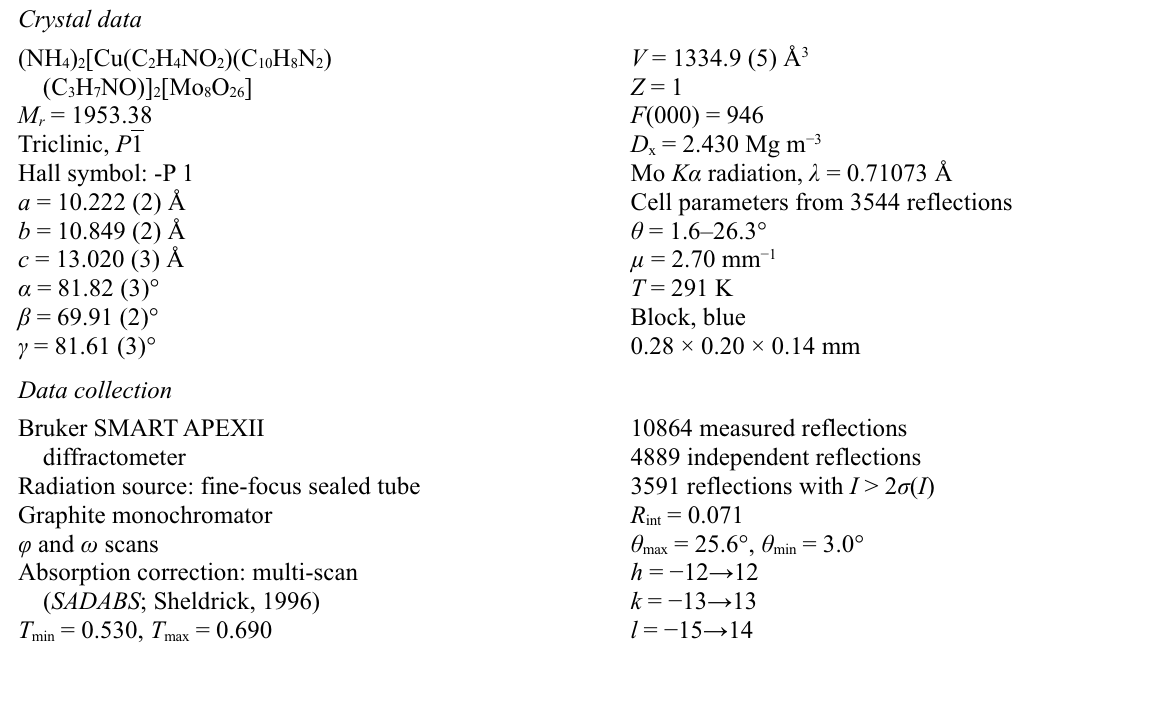
Crystal packing of the title compound. The ammonium ions are drawn as ball. Dotted lines denote hydrogen bonds. Diammonium bis[(2-aminoacetato- κ 2 N , O )(2,2 ′ -bipyridine- κ 2 N , N ′ )(N, N - dimethylformamide- κ O )copper(II)]